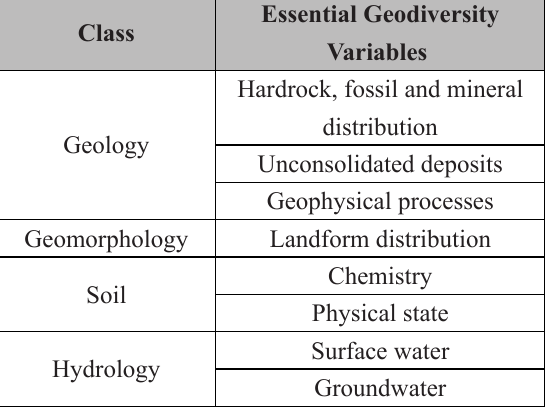
Table 1. Classification of the Essential Geodiversity Variables by Schrodt et al.